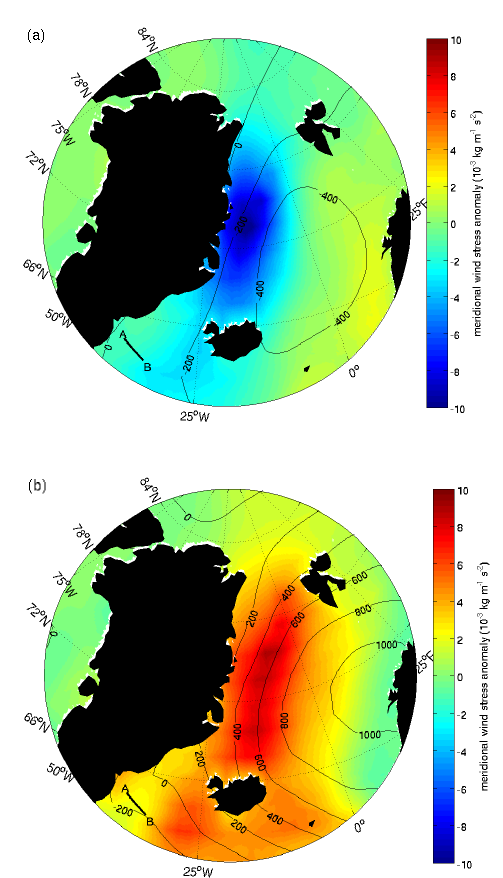
Fig. 10. Maps of the time-lagged correlation coefficient ( p < 0.01) between mooring UK1 salinity anomaly time series shown in Fig. 5a, and NCAR 5 day mean meridional wind stress ( a ) and zonal wind stress ( b ). Time lag is 4 1 / 2 months. Contours indicate the 11-year mean of NCAR meridional and zonal wind stress (10 − 3 kgm − 1 s − 2 ) . Grey indicates no statistically significant correlation. CD, EF and GH are sections used to calculate the volume and freshwater flux of the EGC.